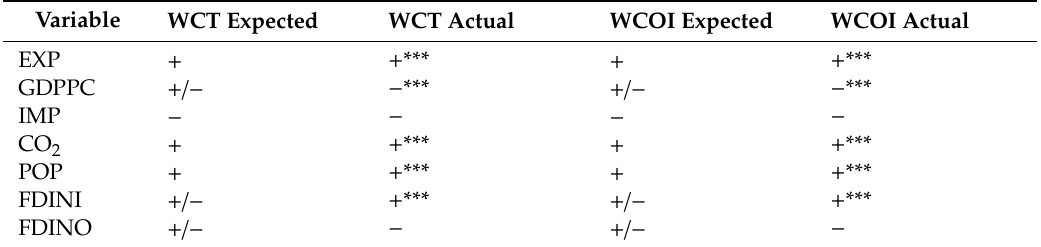
Table 11. Comparison of signs of Regression variables (Australia, Japan, and the UK).